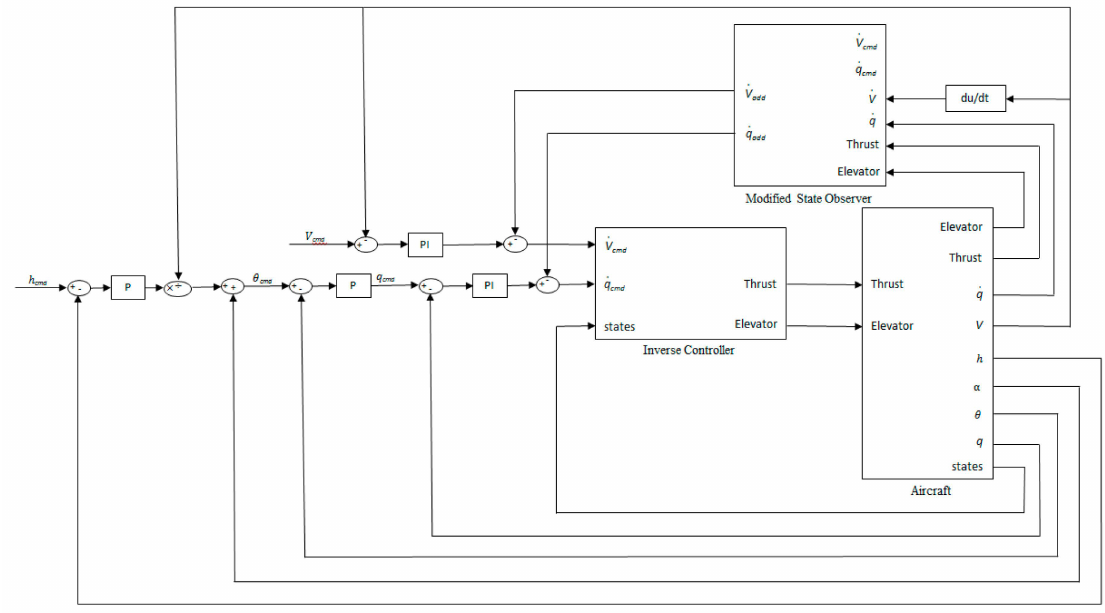
Figure 3. Block diagram of MSO adaptations and PI controller integrated with the Black Kite model and inverse